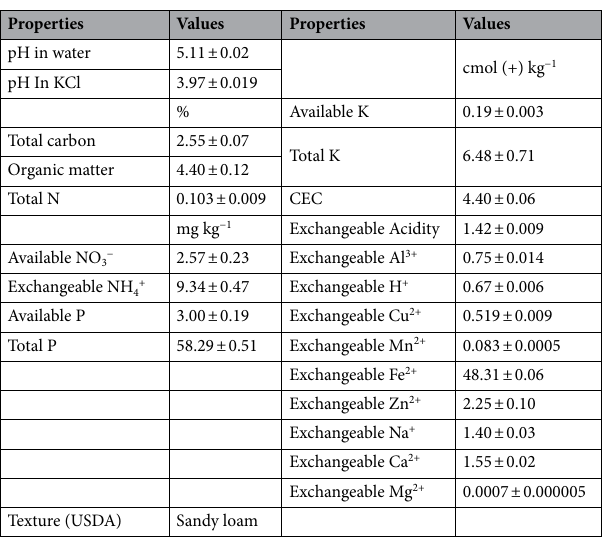
Table 1. Selected physical and chemical properties of Typic Paleudults (Nyalau Series).